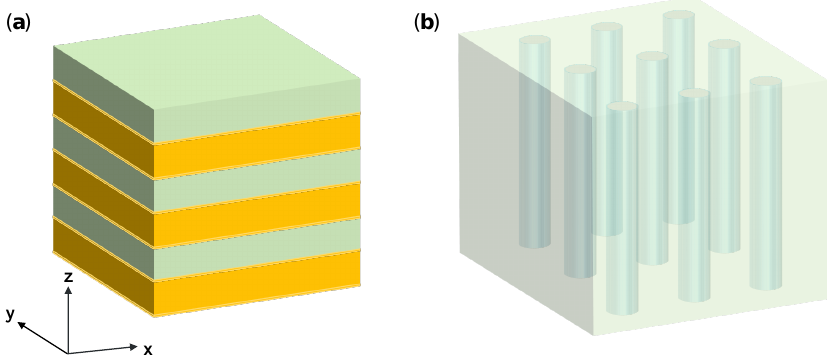
Figure 4. Two typical structures of hyperbolic metamaterials (HMMs). ( a ) Multilayer structure with alternating metallic and dielectric layers. ( b ) Nanowire structure consisting of metallic nanorods embedded in a dielectric host.